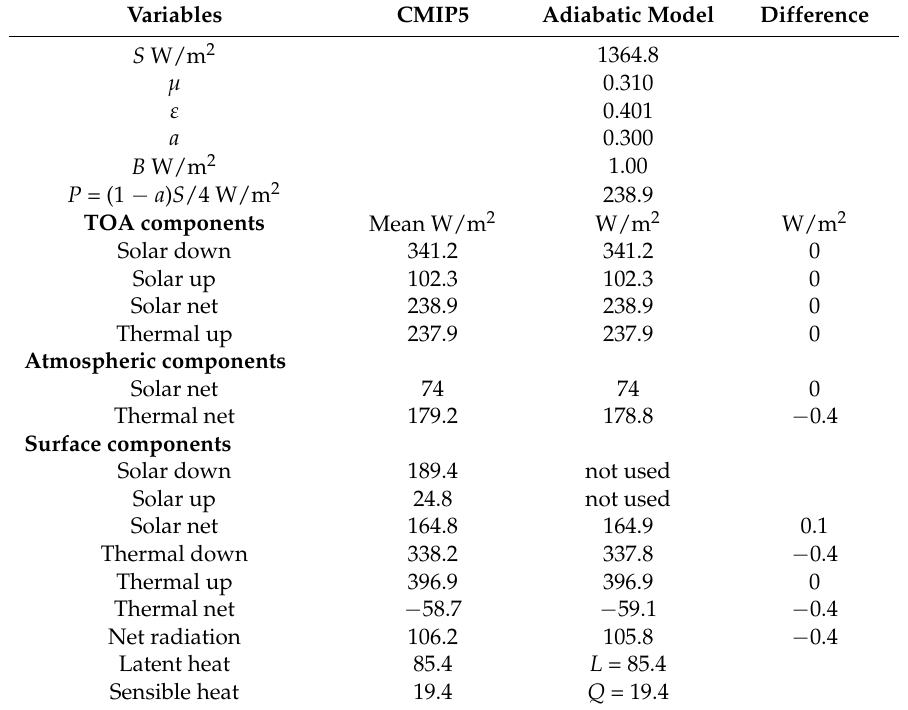
Table 3. Comparison of 22 Coupled Model Intercomparison Project Phase 5 (CMIP5)/ International Satellite Cloud Climatology Project (IPCC) AR5 models with the adiabatic radiative model. Modified after Wild et al.